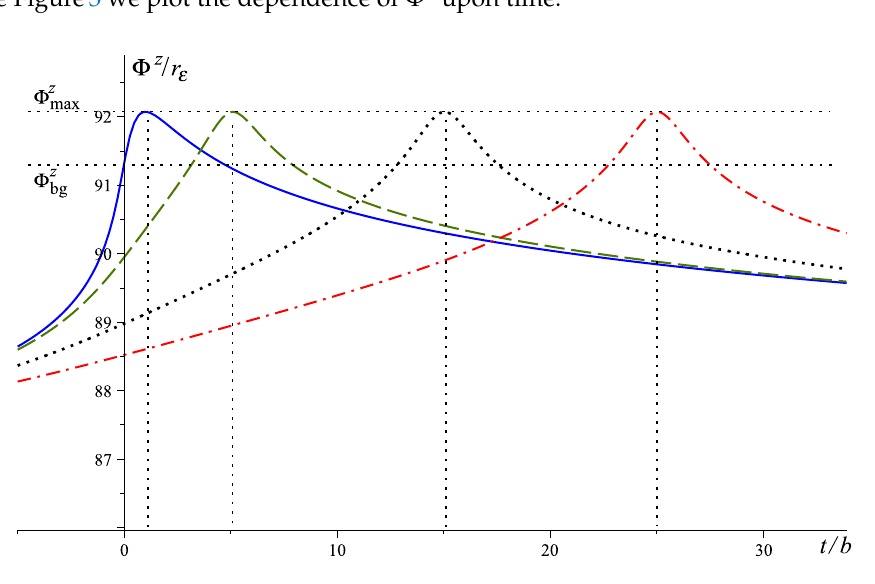
Figure 3. String’s z -deflection (in units r E = 1) as a function of time (in units b = 1) at x / b = 0 (blue solid line), x / b = 5 (green dashed line), x / b = 15 (black dotted line), x / b = 25 (red dashdotted line) for v = 0.5. The conical angular deficit is β (cid:48) = 10 − 4